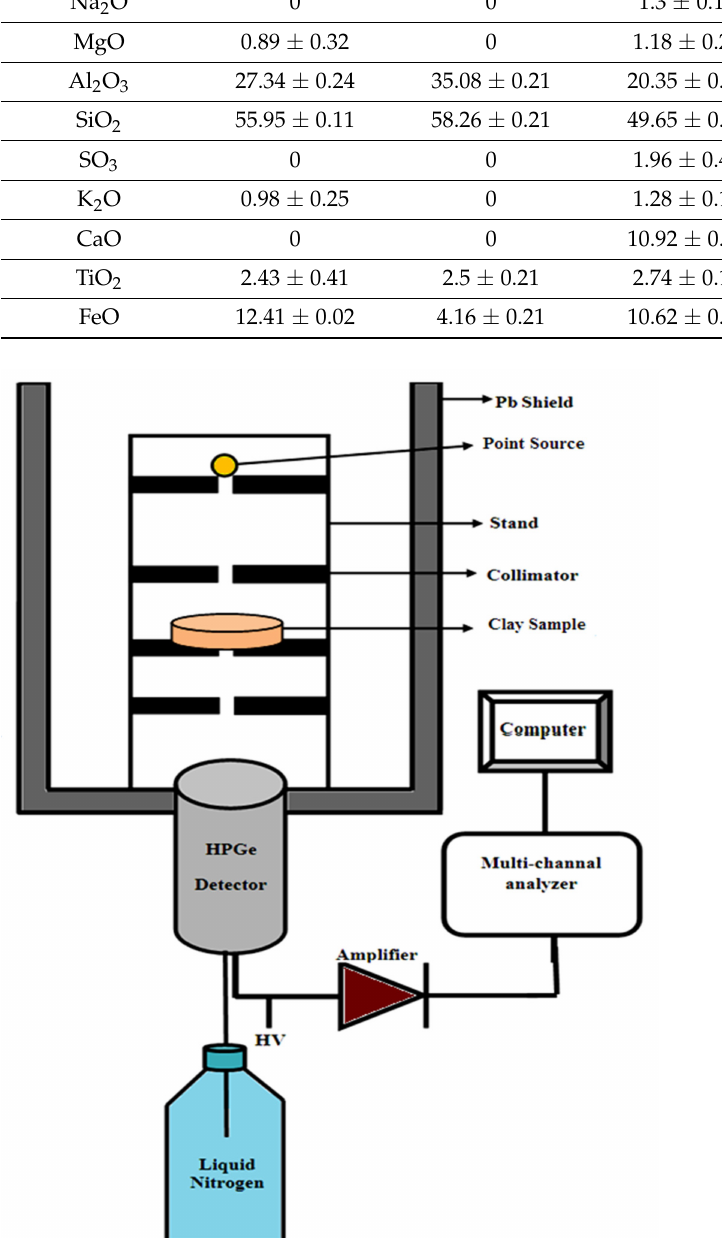
Figure 3. The schematic diagram of the setup used in the present work. The radiation protection efficiency (RPE) was determined for the studied clays to show the most efficient clay from the following equation